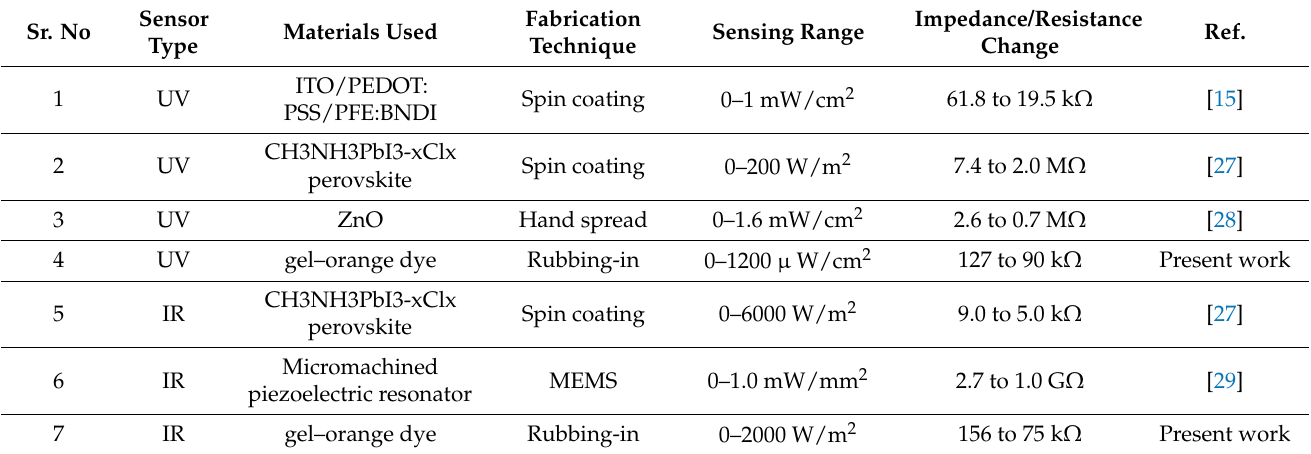
Table 1. Comparison of fabricated sensors with the sensors reported in the